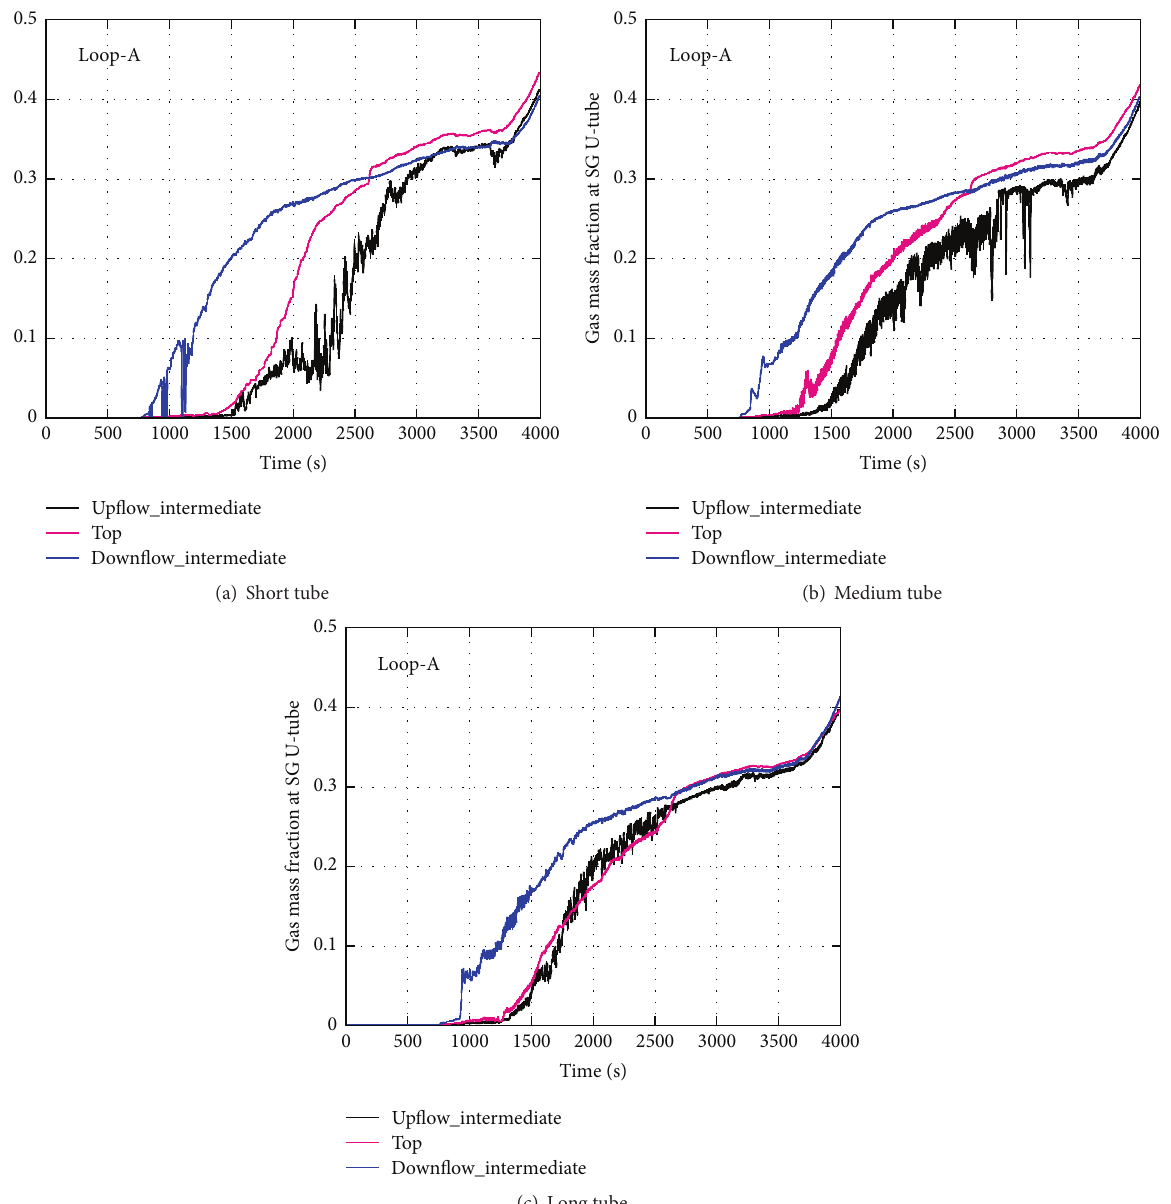
Figure 17: Calculated gas mass fractions at SG U-tubes in loop-A in case of release of dissolved